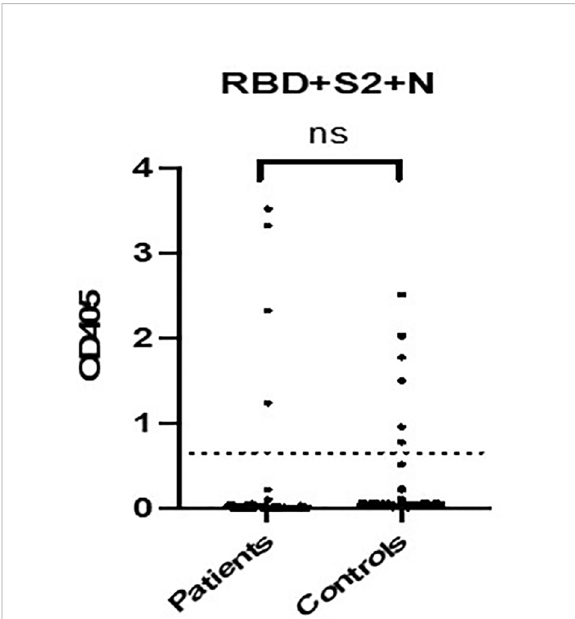
FIGURE 5 Prevalence of antibodies against the combination of the RBD and S2 domain within S protein and the whole N protein in sera from 65 patients and 120 controls, using the “ in-house ” ELISA. The cut-off value had been previously determined using the mean optical density plus 2 standard deviations (SDs) of pre- pandemic controls, represented by the dotted line. Black symbols represent the antibody-binding as Optical Density (OD) value of each serum at 405 nm. The rate of positivity did not differ signi fi cantly between the two groups (p >0.05). ns: Not Statistically Signi fi